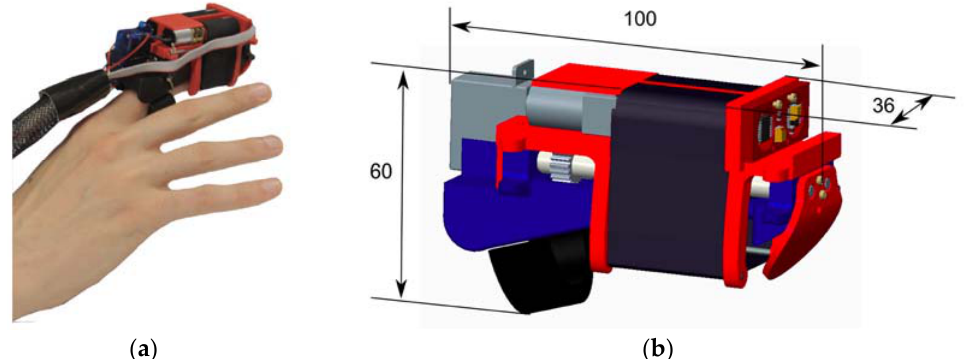
Figure 2. Wearable Fabric Yielding Device (W ‐ FYD) on a user’s finger ( a ); W ‐ FYD CAD design and dimensions (in mm) ( b ). Reproduced from [18], Copyright 2016, IEEE.